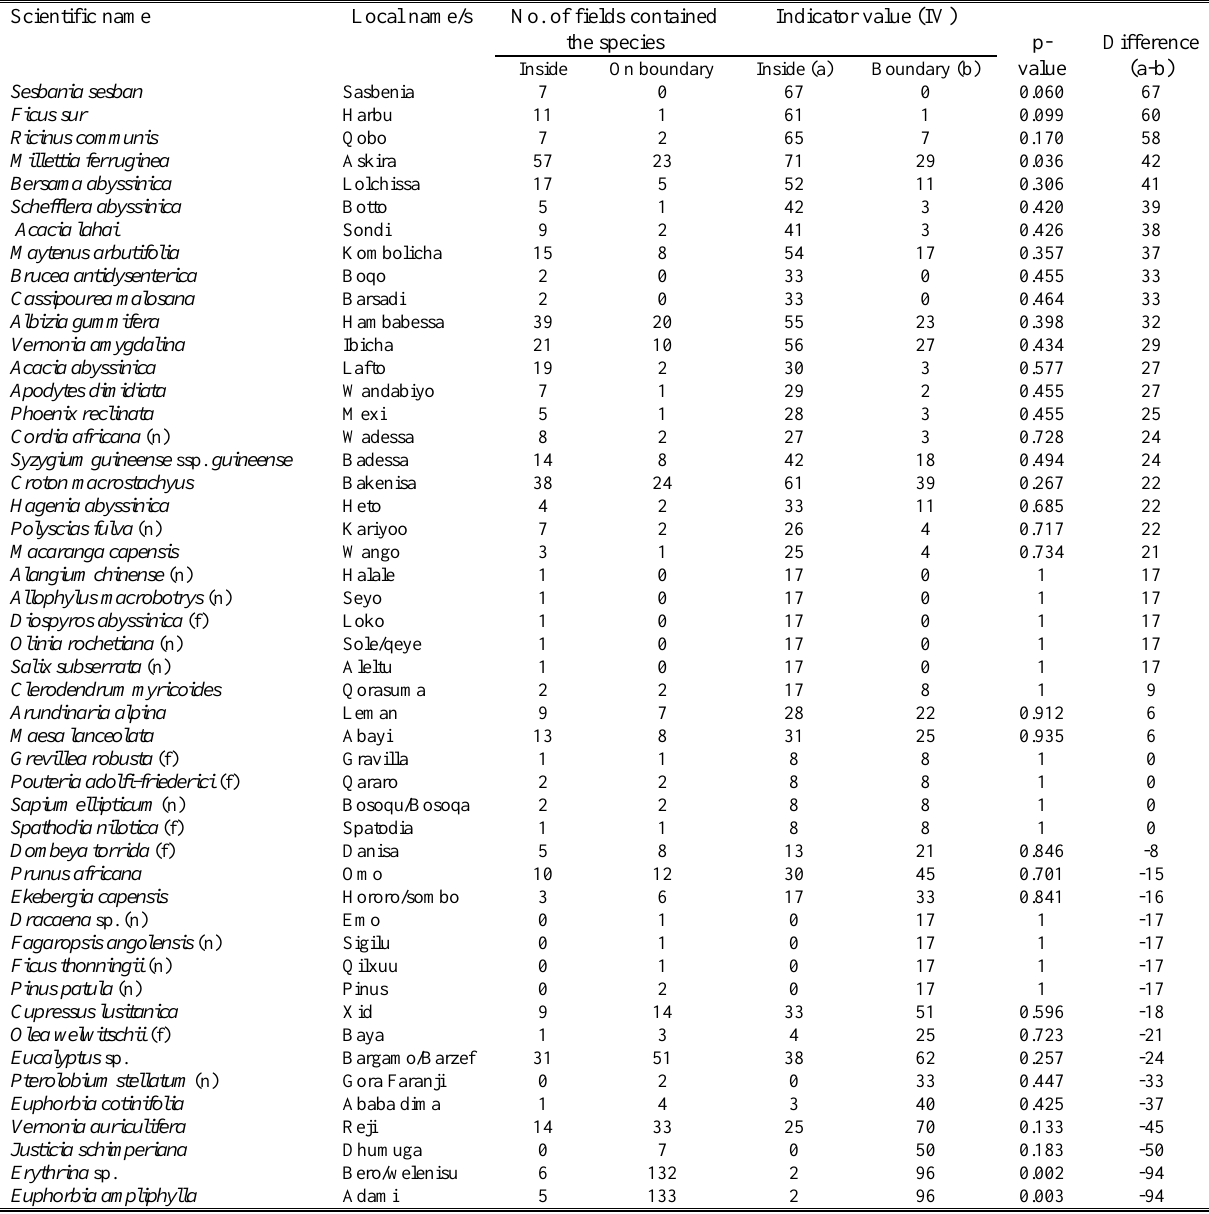
Table A1.1 Indicator species values for trees recorded inside and on boundaries of fields. The table is sorted according to the difference in indicator value, implying that species which are found more inside fields have a positive value, and species found at the boundaries have a negative